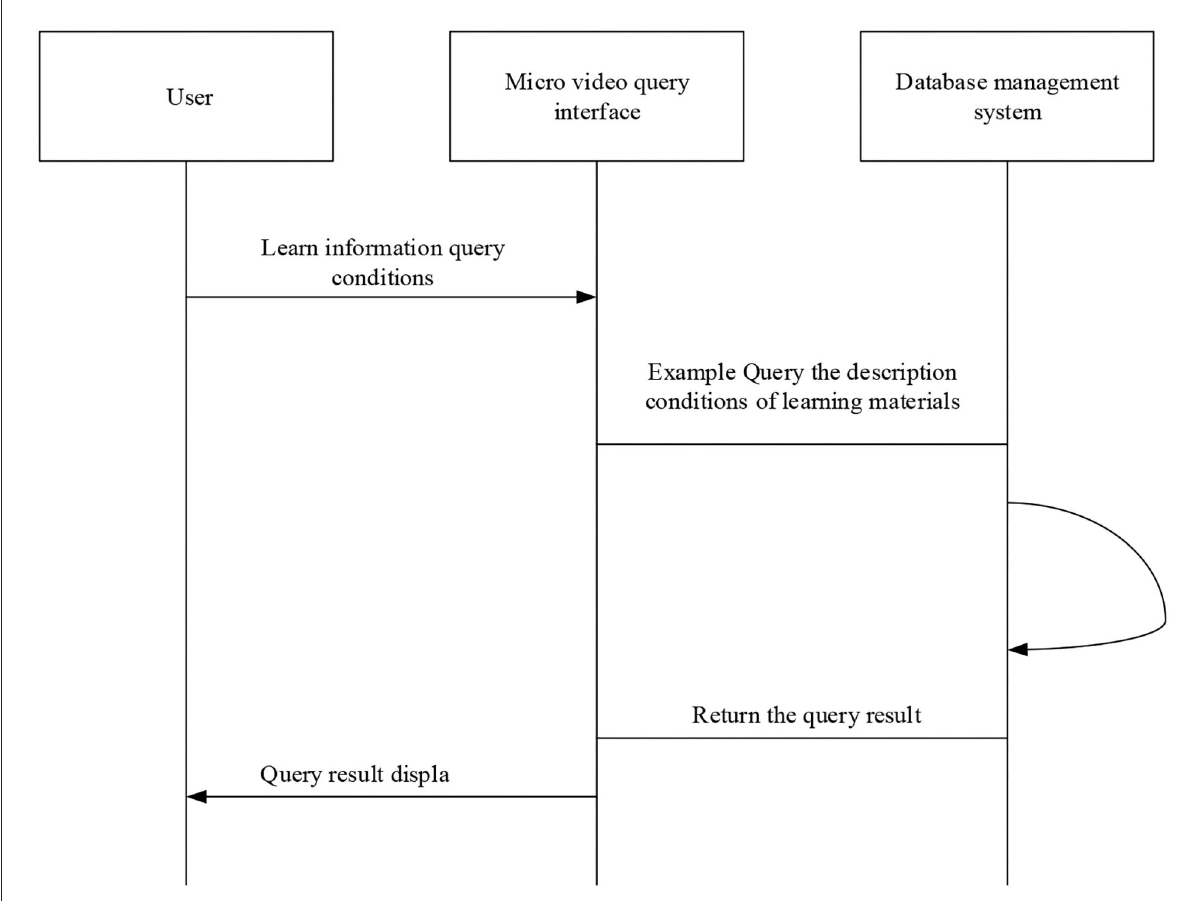
FIGURE13 Sequence diagram of the micro-video